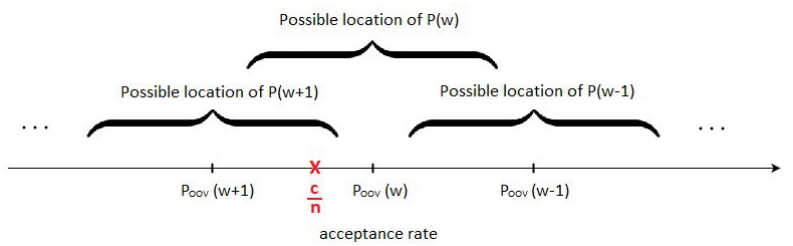
Figure 6. Localization of P ( w ) values using Berry-Eseen upper error